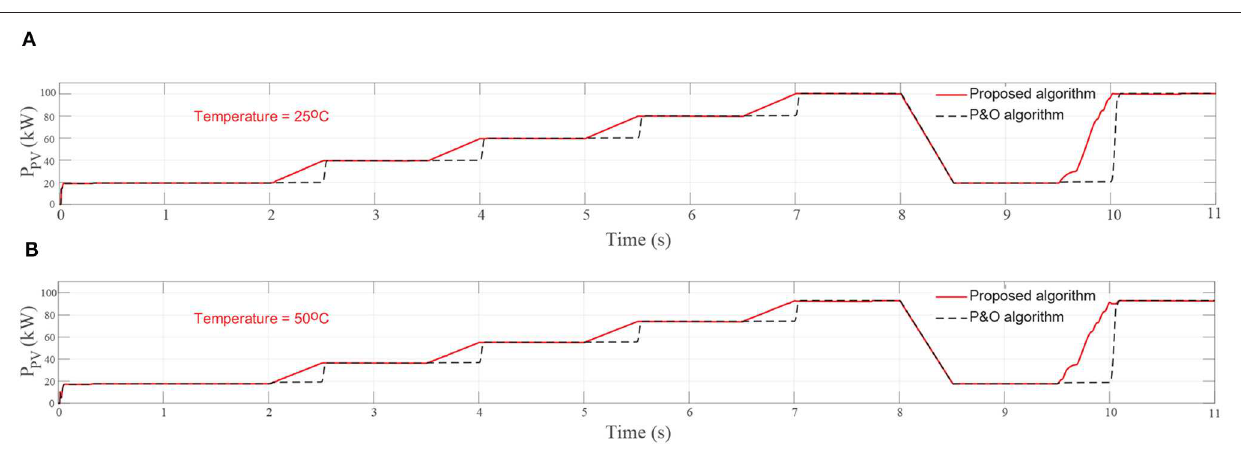
FIGURE 8 | Simulation results for rapid change of solar irradiation and fixed temperature at (A) 25 o C and (B) at 50 o